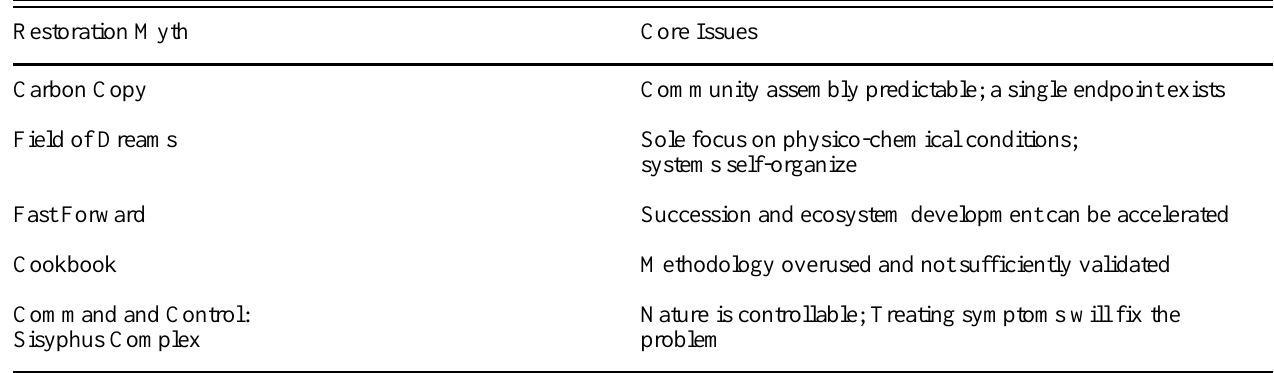
Table 1. The myths of restoration and their core issues Restoration